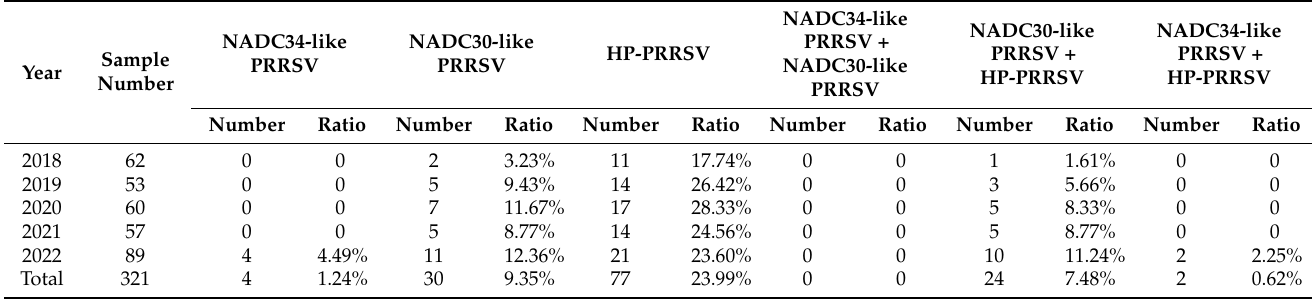
Table 3. Detection results of NADC34-like PRRSV in the archived clinical samples from 2018 to 2022 by real-time RT-